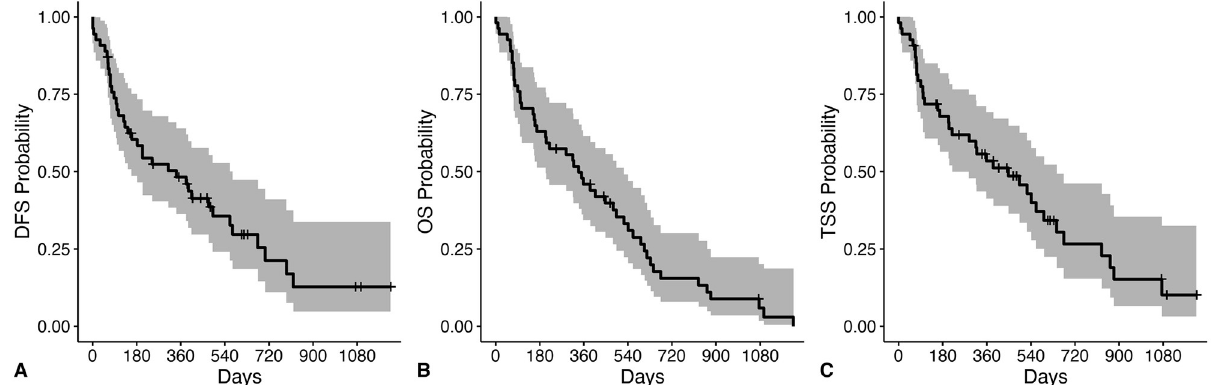
Fig 5. Outcome for dogs with primary lung adenocarcinoma following surgical resection. Disease-free survival (DFS), overall survival (OS), and tumor-specific survival (TSS) curves for 55 dogs with lung adenocarcinoma following surgery. Ticks represent dogs censored from analysis and shaded regions represent the 95% confidence interval (CI). Dogs were censored from DFS if they were free of disease at the time of last follow-up. Dogs were censored from TSS if they were alive at the time of last follow-up or died due to a known cause unrelated to a lung tumor. (A) The median DFS was 342